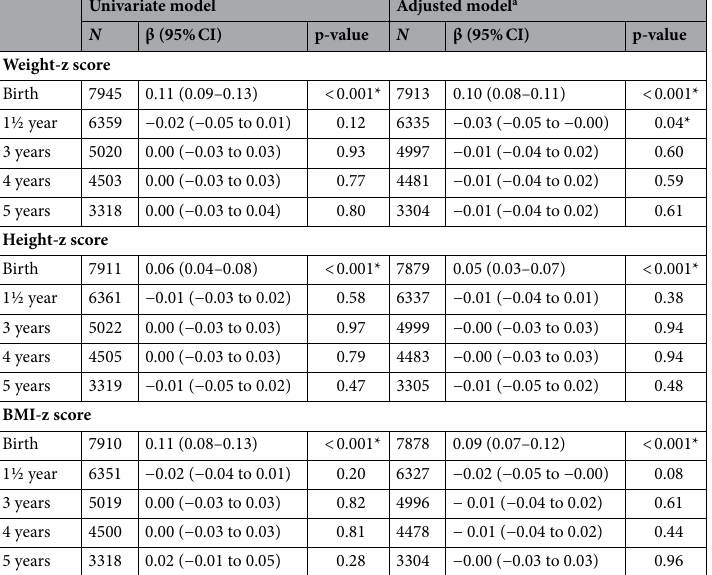
(Table 3). For every increase in maternal blood glucose level of 1 mmol/L, the birth weight z-score increased 0.10 (95% CI 0.08–0.12), birth length z-score increased 0.05 (95% CI 0.03–0.07) and BMI z-score at birth increased 0.09 (95% CI 0.07–0.12) in the adjusted models. At 1½ years we observed an inverse relationship between ma- ternal glucose level during pregnancy and weight z-score (p < 0.036). For every 1 mmol/L increase in maternal blood glucose level the weight z-score at 1½ years decreased with 0.03 (95% CI −0.05 to −0.00) in the adjusted model. At all other ages there was no relationship between the maternal blood glucose level during pregnancy and anthropometric data of the child in the adjusted models. We ran similar analyses on imputed datasets for smoking in pregnancy week 30–32 derived from the original cohort since 8.4% of individuals were missing data on this variable. There were no differences in results when compared the individuals with incomplete data on smoking. Linear mixed effect model analyses. The range of weight z-score, height z-score and BMI z-score, between low- est and highest glucose quartile, were larger at birth than at 1½, 3, 4 and 5 years of age (Fig. 2 and Supplementary Tables S1–S3). We showed a positive relationship between maternal glucose quartiles and weight z-score, height z-score and BMI z-score at birth. Compared with children born to mothers with glucose level within quartile one (Q1), children to mothers with glucose level within quartile two (Q2), three (Q3) and four (Q4) had signifi- cantly higher weight and BMI z-scores at birth. Further, those with glucose level within Q3 and Q4 had higher height z-score at birth (Supplementary Tables S1–3). We found an inverse relationship between maternal glucose quartiles and weight z-score growth trajectory from birth to 1½, 3, 4 and 5 years of age. The decrease in weight z-score were least in children to mothers with glucose level within Q2 and greatest for Q4 compared with children to mothers with glucose level within Q1 (Supplementary Table S1). We found inverse relationships between glucose quartiles and growth trajectories, with a greater decrease in height z-score for children to mothers with glucose level within Q2 from birth to 1½ years and for Q3 and Q4 from birth to 3, 4 and 5 years compared with children to mothers with glucose level within Q1 (Supplementary Table S2). We found no difference in height growth trajectories between children to mothers with glucose level within Q2 compared to children to mothers with glucose level within Q1. Greater decreases in BMI z-scores were noted in children to mothers with glucose level within Q2, Q3 and Q4 from birth to 1½ years of age compared with children to mothers with glucose level within Q1. Furthermore, there was a greater decrease in BMI z-score for children to mothers with glucose level within Q3 and Q4 from birth to 3 years and for Q2, Q3 and Q4 from birth to 4 and 5 years of age compared with children to mothers with glucose level within Q1 (Supplementary Table S3). We found no difference BMI z-scores between children to mothers with glucose level within Q2 compared to children to mothers with glucose level within Q1 from birth to 3 years of age.